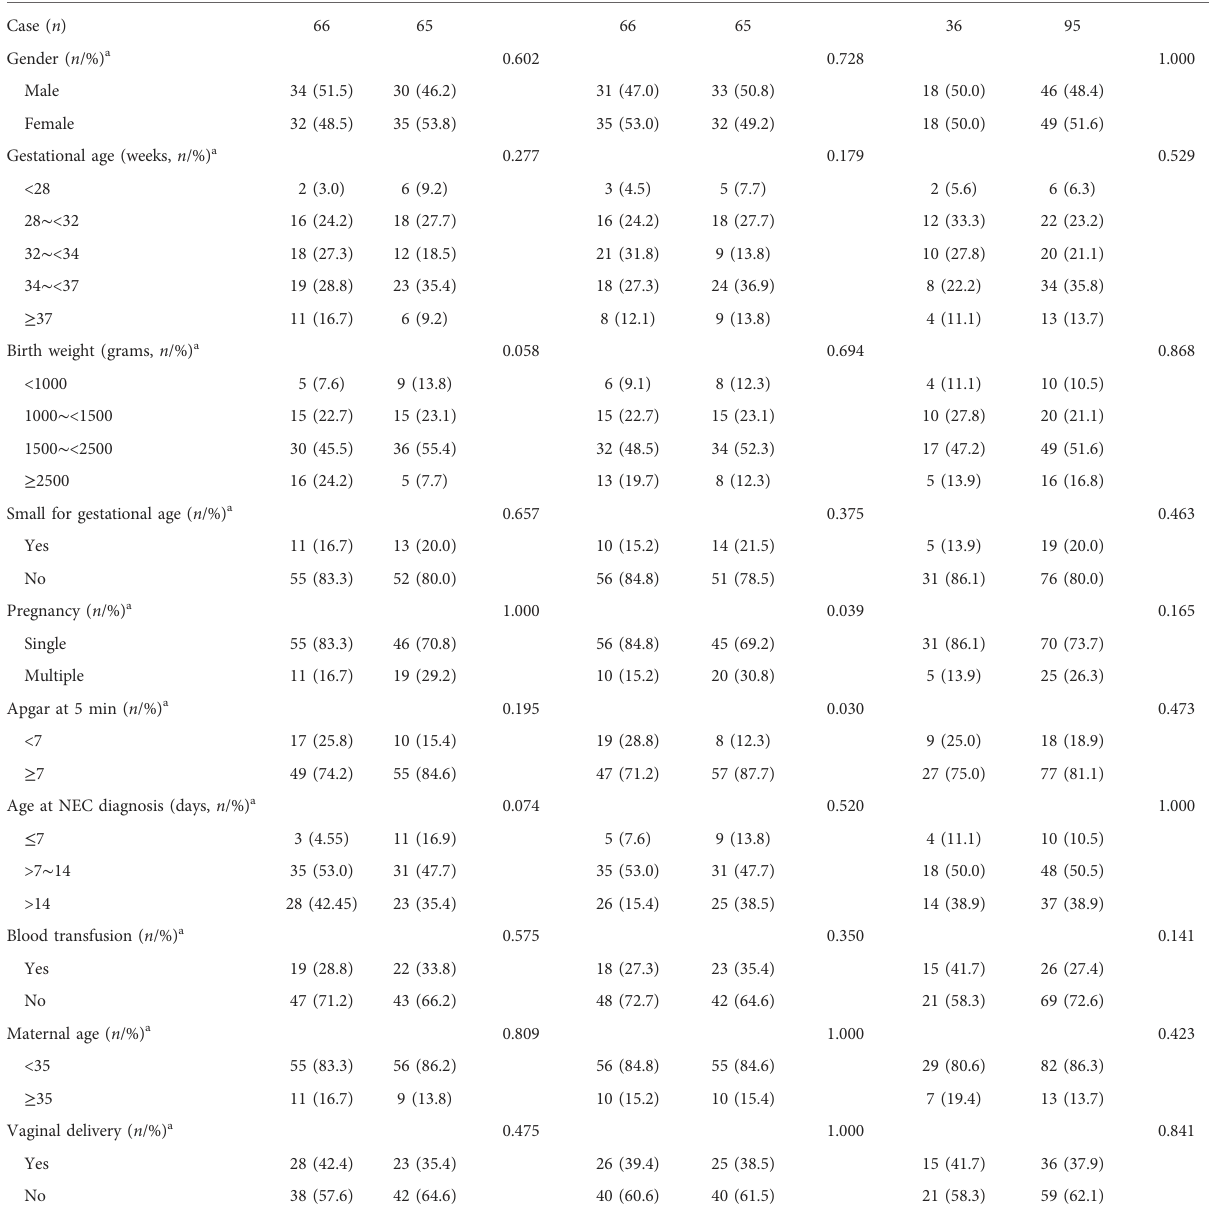
TABLE 1 Correlations of SII, PLR, and NLR with general demographics of neonates with NEC.